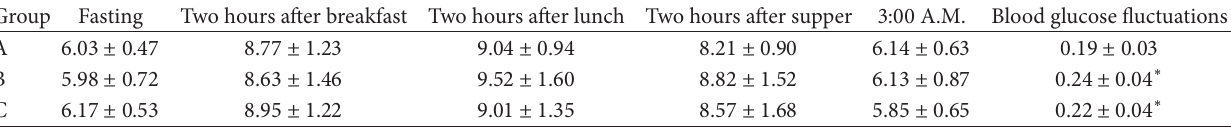
Table 4: Comparison of blood glucose levels in mmol/L ( ± standard deviation) at different times and blood glucose fluctuations.